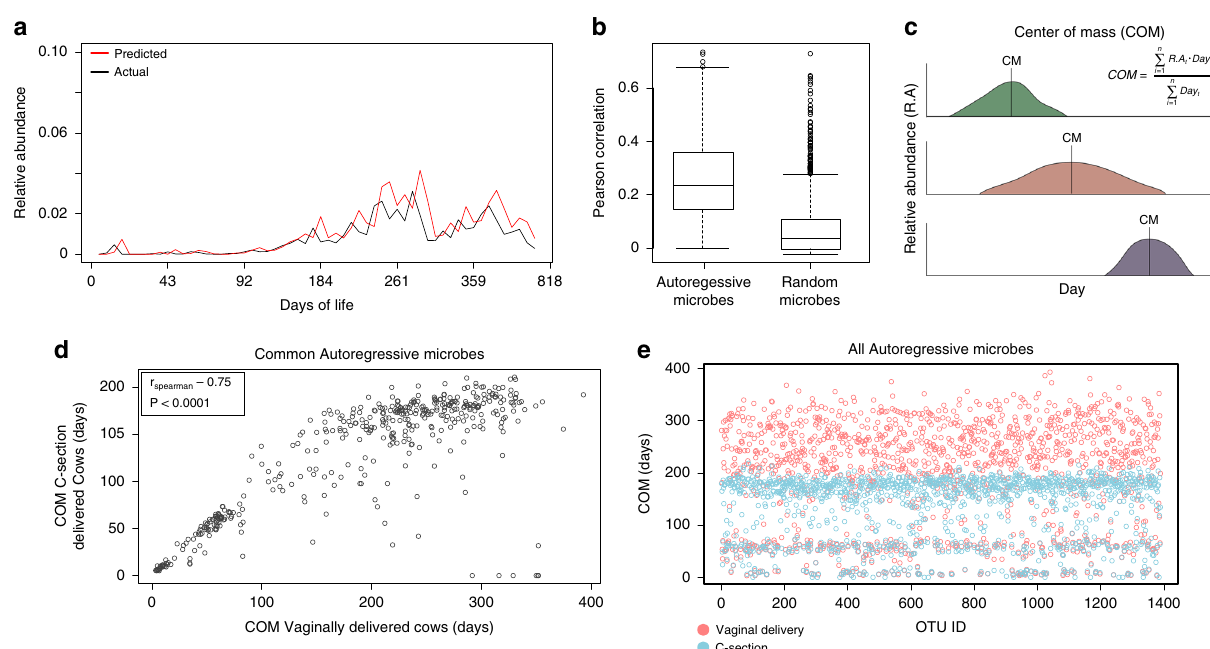
Fig. 5 Community dynamics is independent of mode of delivery but there is a time shift in species dynamics. a Prediction of a single microbe ’ s behavior by MTV-LMM method (see Methods section). Black line represents the actual behavior of a given microbe; red line represents predicted behavior. b Autoregressive microbes are more predictable than any other randomly selected microbes. Pearson correlation between predicted and actual community composition for autoregressive microbes compared to a random set of microbes. The random set was picked using a permutation test ( n permutations = 1000) in which at each iteration, 495 microbes are picked and used as predictors for the next time point. c Illustration of the center of mass (COM) where i is the cow ID (1 – 45), R.An calculation and clustering. COM is the weighted average for an OTU ’ s relative abundance over time. COM ¼ Day t i ¼ 1 is the relative abundance of a species at time point t , Day t is the day of life when the sample was taken (1 – 831). d COM is lower for the C-section-delivered autoregressive microbes. Clustering using the K-means method for the MTV-LMM microbes. Each dot represents the mean COM of autoregressive microbes in a particular cow. Only microbes found to be autoregressive in one mode of delivery, originating either from C-section (blue) or vaginal delivery (red), are presented for each cow. Stars represent the center of the cluster for each delivery mode. Each axis represents the COM values for C-section ( Y - axis) and vaginal-delivery mode ( X -axis). e Time shift between C-section and vaginal delivery in all autoregressive microbes, with lower COM for microbes from C-section cows. Average COM for all MTV-LMM microbes (OTU index on the X -axis, average COM on the Y -axis) displayed for either vaginal delivery (red) or C-section (blue), showing a time shift in the COM dependent on the mode of delivery for all OTUs. Each dot represents the COM for a single OTU averaged across all cows within one of the two modes of delivery. Source data is provided as a Source Data fi